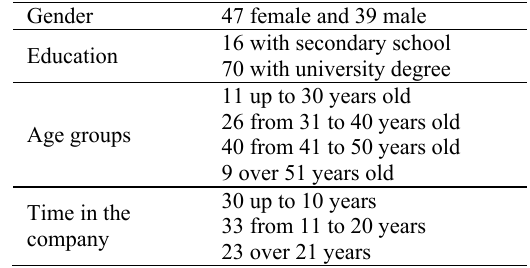
Table 1. Characterization of the